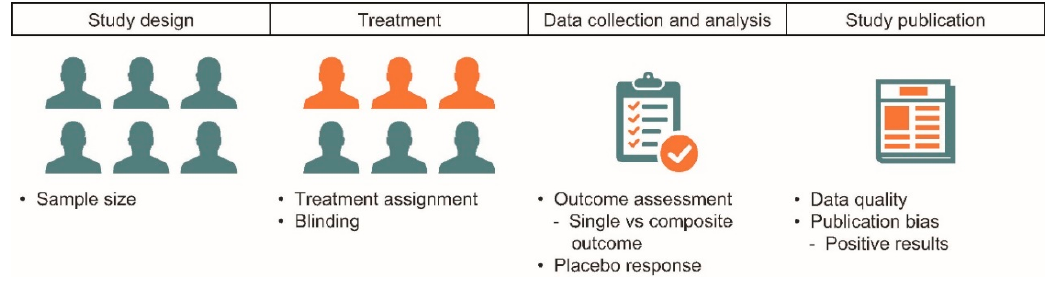
Figure 2. Methodologic characteristics assessed for clinical studies of antidepressant treatment in patients with irritable bowel syndrome.